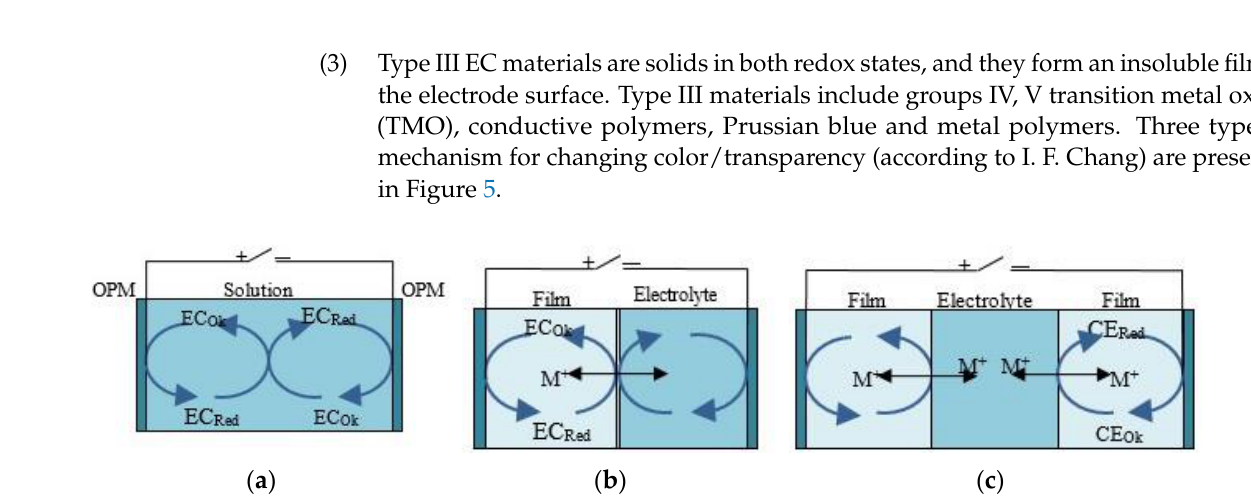
Figure 5. Types of ECW: ( a ) type I (solution); ( b ) type II (hybrid); ( c ) type III (battery-powered); EC—electrochromic layer; CE—counter-electrode layer; TCO—inorganic oxide. The electrochromic reaction can be described by the following equation: